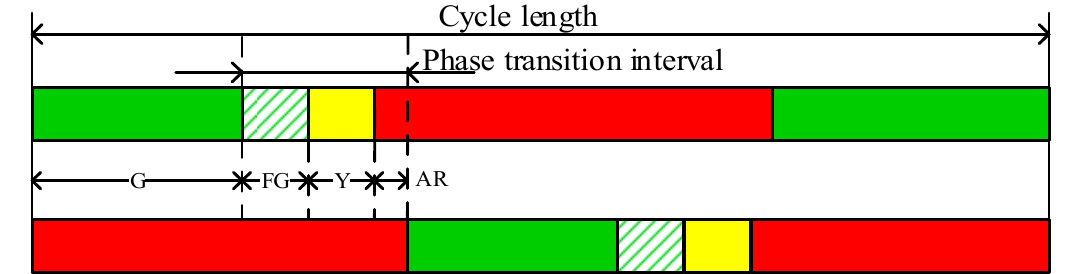
Figure 1. Illustration of the phase transition interval at the study intersections.